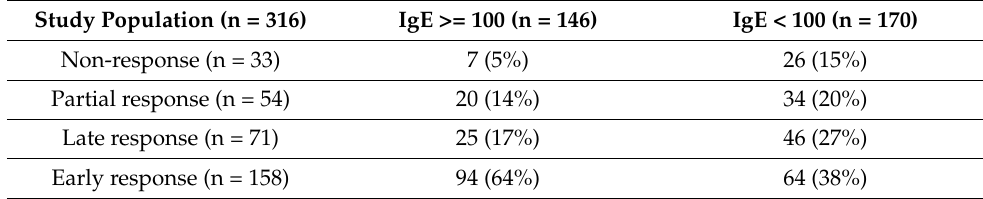
Table 3. Clinical response to omalizumab in patients showing different baseline IgE